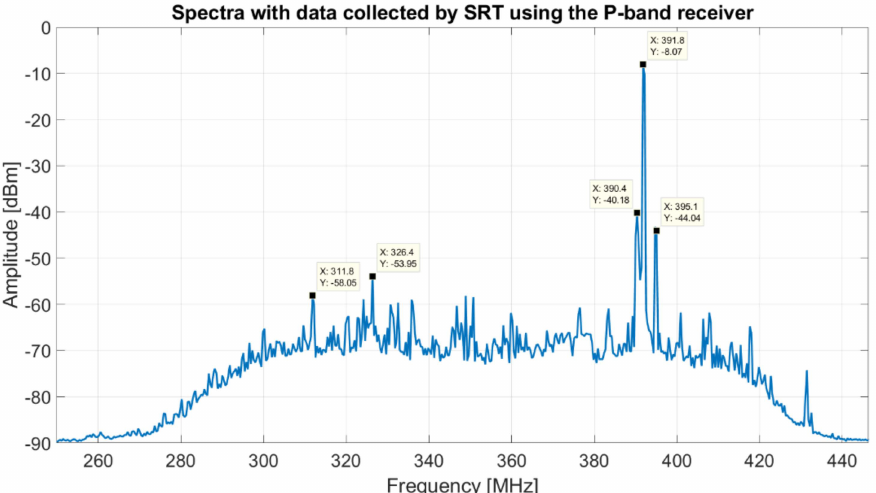
Figure 9. Spectra with data collected by SRT using the P-band receiver, with the selection of the BPF centered at 357.5 MHz with a bandwidth of about 120 MHz (model 5B340-357.5/T120-O/O from K&L), and using the Rodhe and Schwarz FSV40 spectrum analyzer as